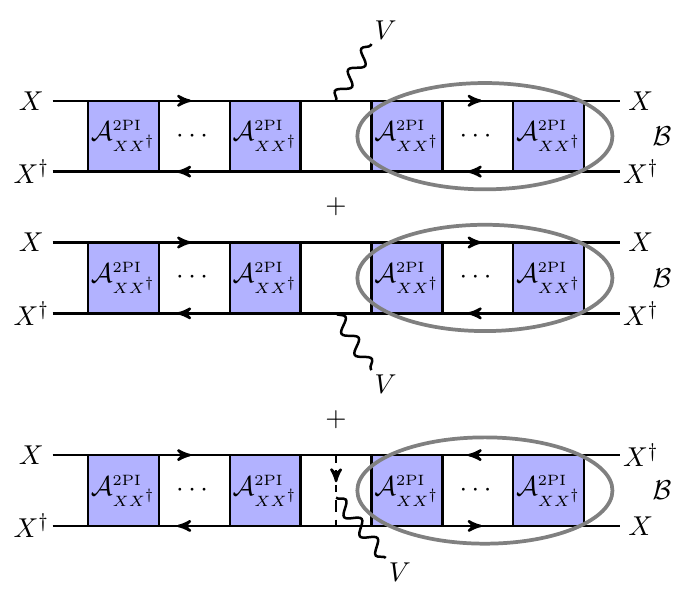
Figure 2 . The capture into bound states via emission of a vector boson (BSF B ( XX y ) + V . While the bottom diagram appears to be naively of higher order, the momentum exchange along the two (cid:8) propagators scales with the couplings, and renders this diagram of the same order as the two upper diagrams. We refer to appendix C for the computation.